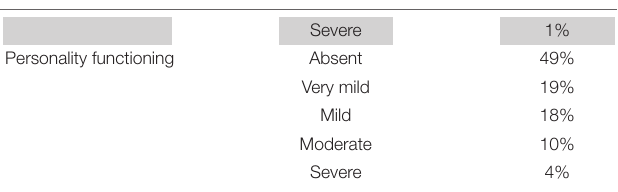
TABLE 3 | Severity of transversal symptoms in